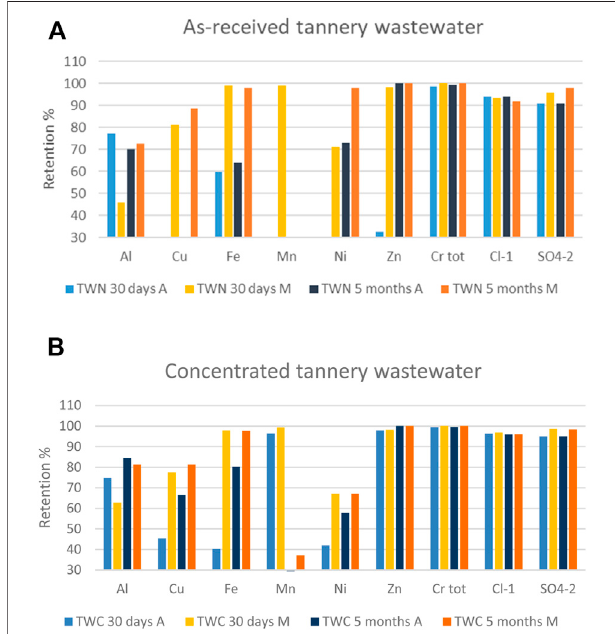
FIGURE 2 | Comparison of retained percentage of elements and anions by part of clay-based geopolymers (indicated with A) vs. metakaolin-based geopolymers (indicated with M) after 30 days and 5 months of curing time. The tannery wastewater was added as-received (A) or concentrated 10 times (B)